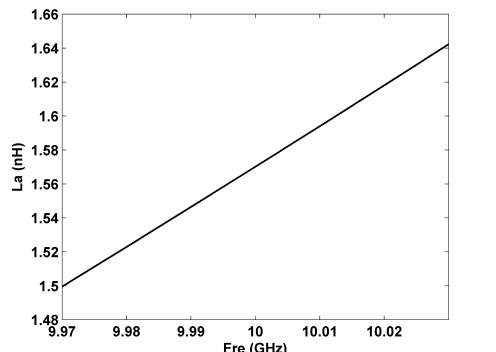
Figure 7. The equivalent inductance of the directional coupler